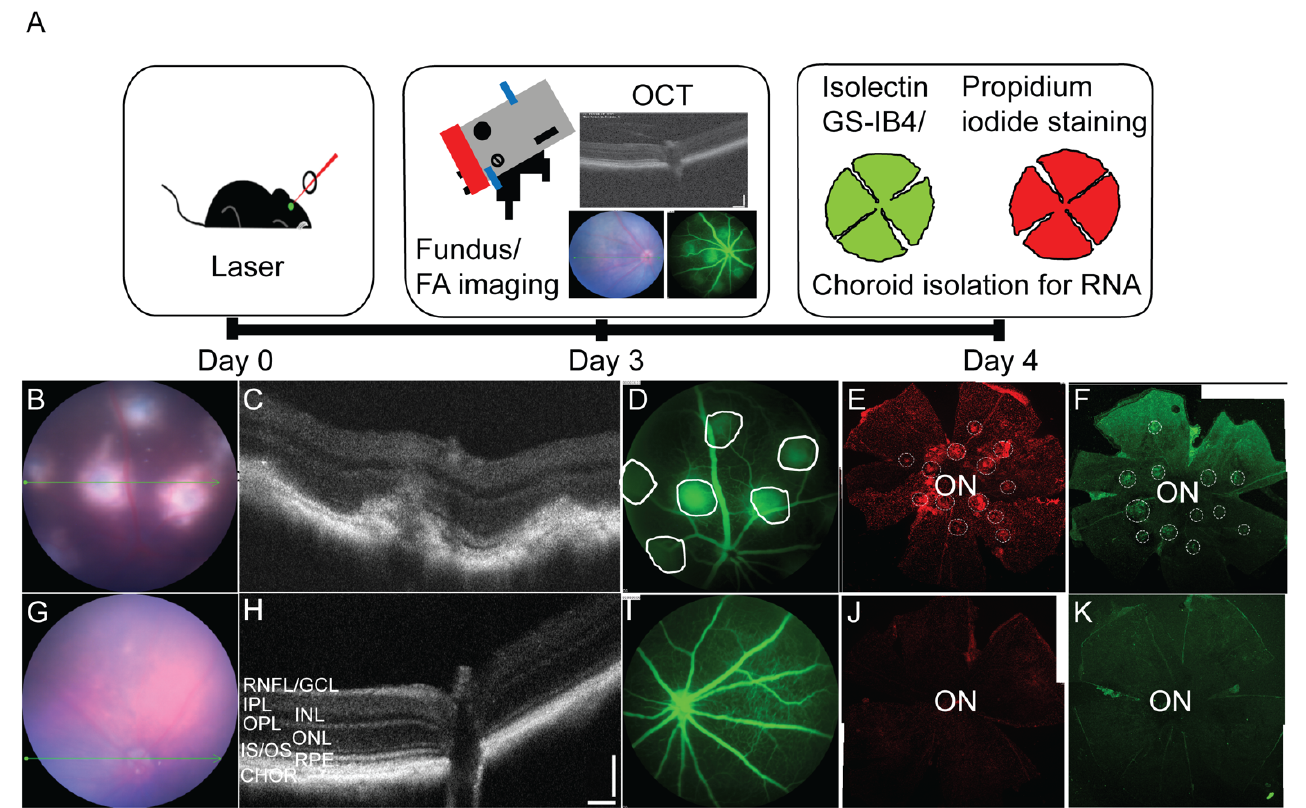
Figure 5. Laser induced CNV mouse disease model paradigm. ( A ) Schematic of the experimental plan. On day 0 lesions in mice eyes are induced with laser and imaged at day 3 with optical coherence tomography (OCT), fundus and fluorescein angiography. On day 4, eye tissues are collected for flatmount staining with isolectin GS-IB4 and propidium iodide and choroid is isolated for RNA extraction. In vivo evaluation of mice 3 days post lasering occurred in 15–17 month mice. Representative images are shown here. ( B , G ) Fundus images of the posterior eye showing the extent of the CNV lesions. ( C , H ) OCT images displaying cross-sections of the lesions (corresponding to the green line in ‘( B )’ or ‘( G )’). ( D , I ) Regions of leakage (dotted line circles) from the CNV lesions are visible in fluorescein angiography images. ( E , J ). A montage of the entire choroidal flat mount was created by overlapping and combing 4–5 images captured at lower magnification (4 × ). Choroidal flat mounts from control and CNV lasered mice stained with propidium iodide and ( F , K ) isolectin GS-IB4Representative image is shown to demonstrate CNV lesions (dotted line circles demarcate lesions). CNV: Choroidal neovascularization; ON: Optic nerve head; RNFL/GCL: retinal nerve fiber layer/ganglion cell layer; IPL: inner plexiform layer; INL: inner nuclear layer; OPL: outer plexiform layer; ONL: outer nuclear layer; IS/OS: inner segment/outer segment; RPE: retinal pigment epithelium; Chor: